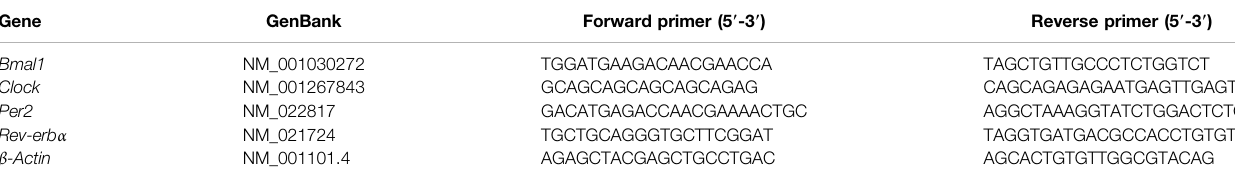
TABLE 1 | List of primers used for mRNA expression of clock genes in human